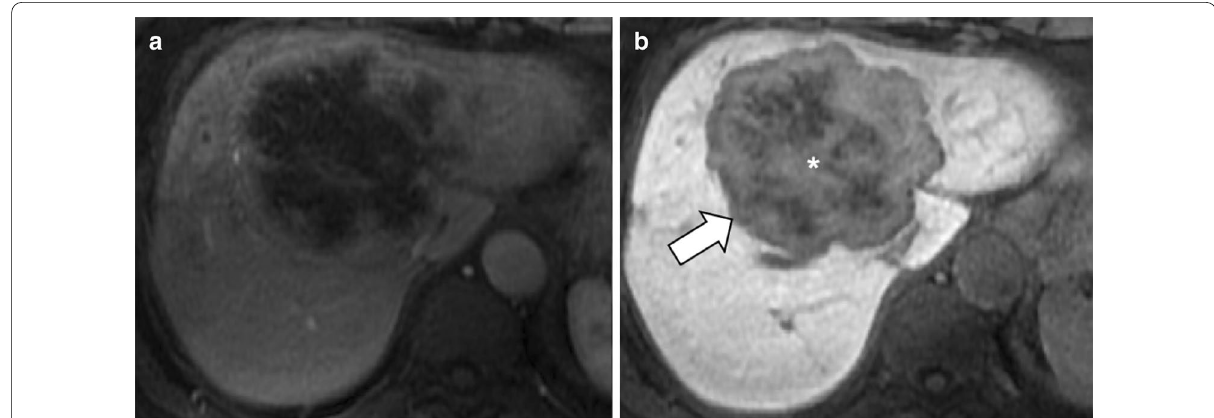
Fig. 11 A 71‑year‑old woman with cholangiocarcinoma. Gadoxetate disodium‑enhanced MRI shows an intrahepatic mass‑forming cholangiocarcinoma with ( a ) continuous rim enhancement on hepatic arterial phase and ( b ) a target pattern on hepatobiliary phase with peripheral hypointense rim (arrow) and inhomogeneous contrast media uptake with a central enhancing area (asterisk) likely related to fibrous stroma